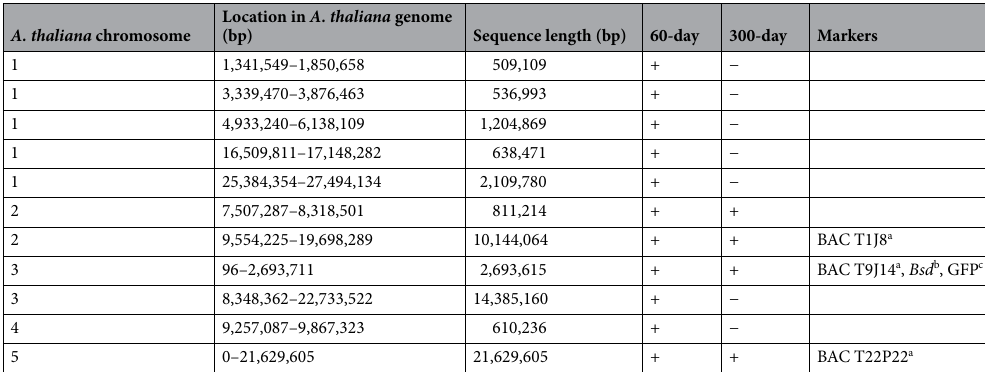
Table 1. Arabidopsis thaliana genome regions present in the 60-and 300-day-old hybrid cell lines. Markers of Arabidopsis genomic region: a Bacterial artificial chromosome (BAC); b Blasticidin S resistance ( Bsd -resistance) gene and c Green fluorescence protein (GFP) gene localized by Wada et al. 15 in hybrid cell. + : present, −: not